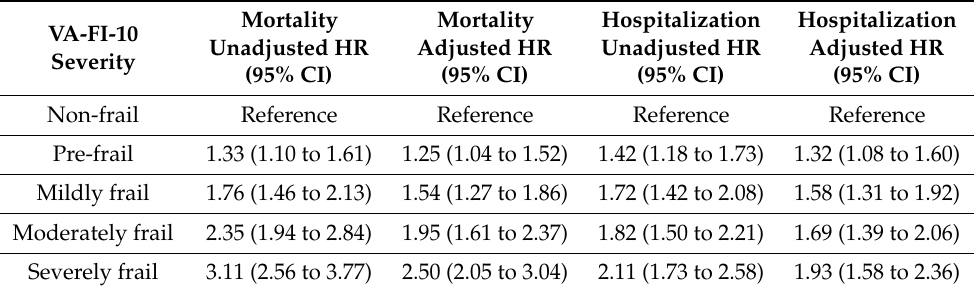
Table 3. Univariable and multivariable Cox proportional hazards regression models estimating the association of VA-FI-10 with overall mortality and time to hospitalization among 4294 veterans with